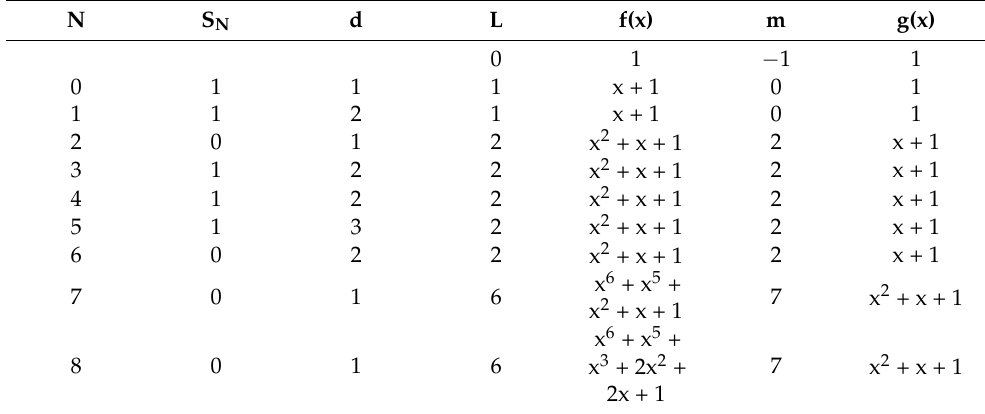
Table 2. Example of the Berlekamp–Massey algorithm